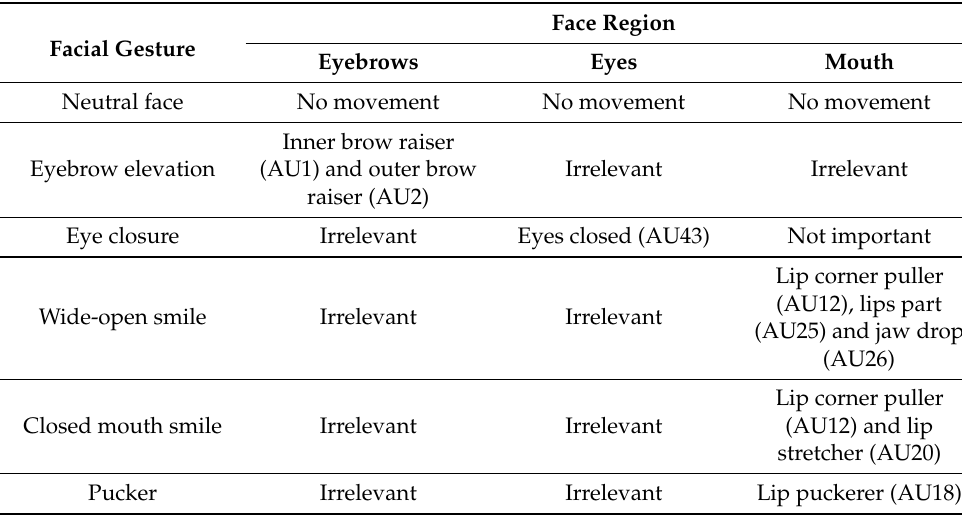
Figure 2. Framework of the proposed facial palsy gesture recognition system. Table 1. General description of the facial